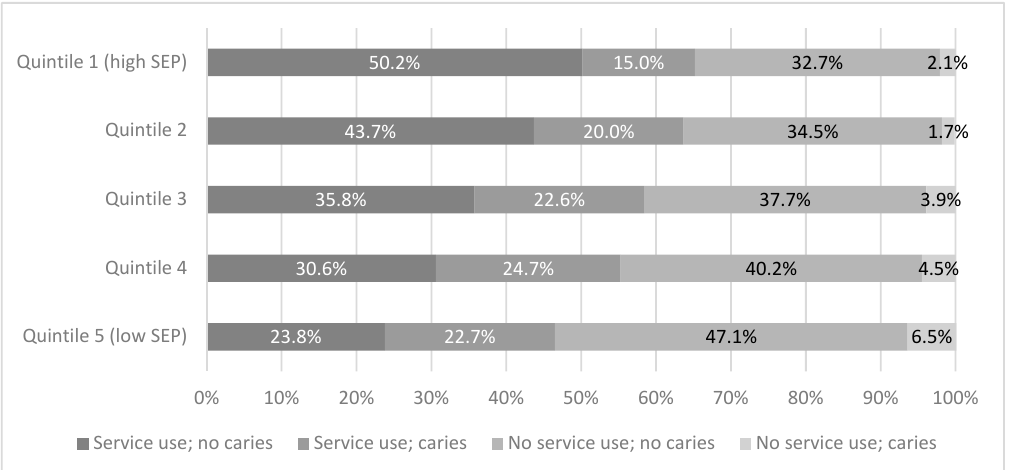
Figure 4. Service use in the previous year with relation to caries experience reported in the previous two years for each SEP quintile at age eight to nine years.